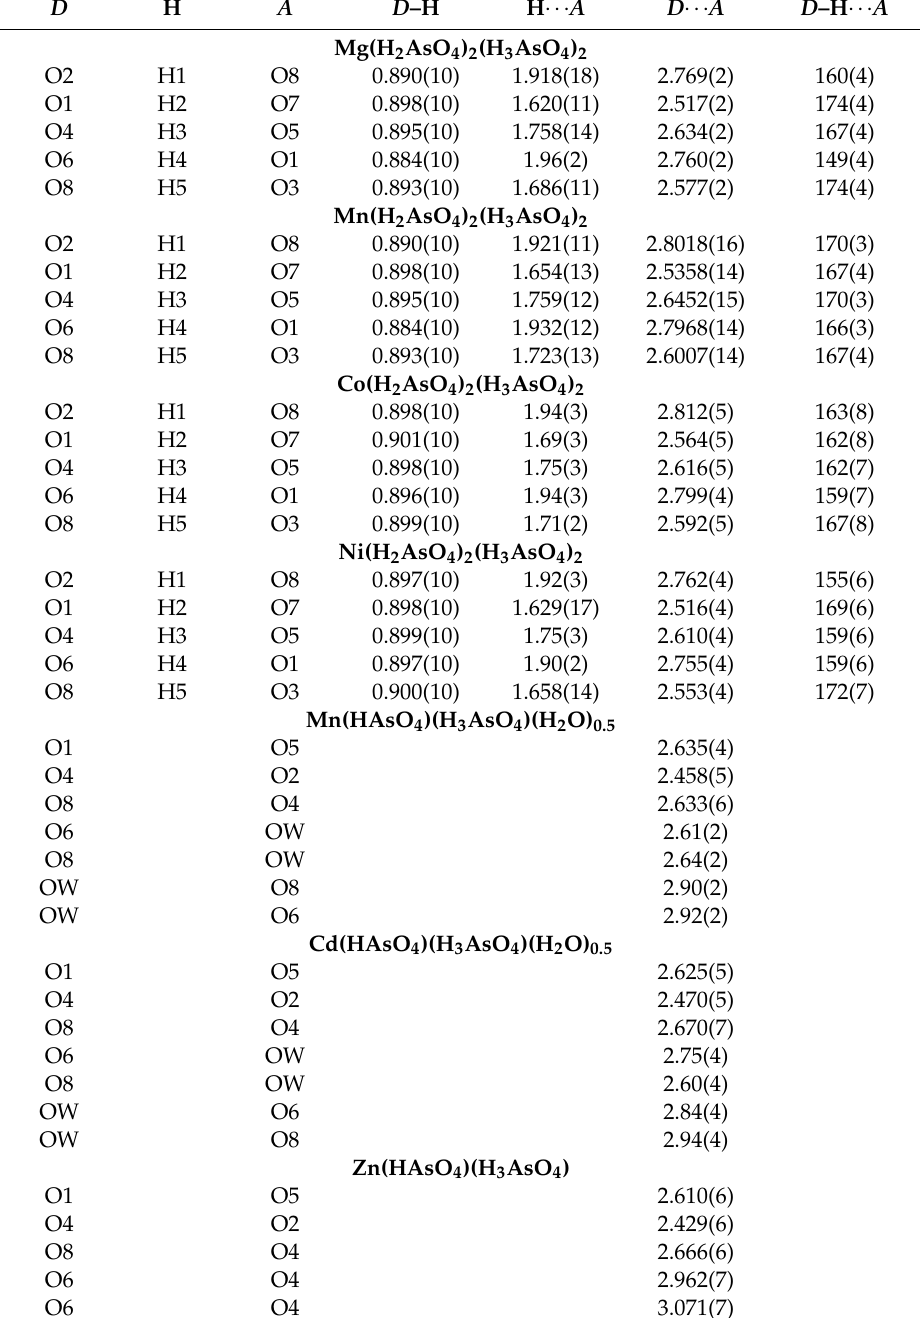
Table 2. Details of the hydrogen bonding geometry / Å, ◦